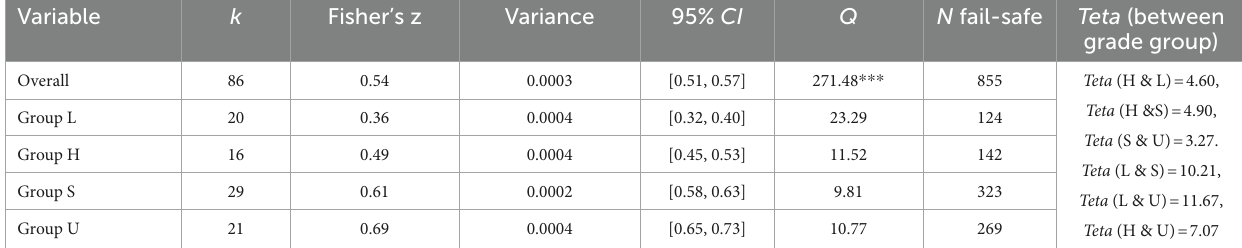
TABLE 2 Correlation of overall effect between grammatical knowledge and reading comprehension with subgroup analysis. Variable